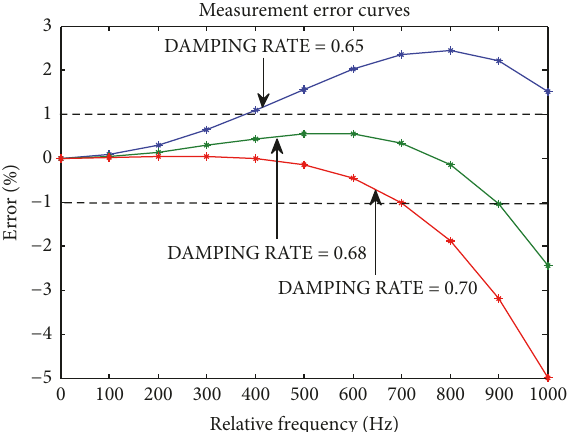
Figure 11: Measurement error as a function of relative frequency for three values of damping rate in the case where the relative frequency is varied from 0 to